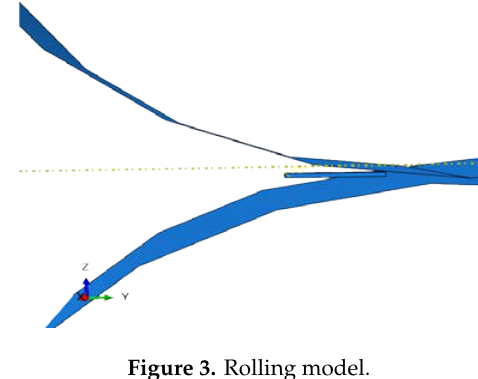
Figure 3. Rolling model. Figure 3. Rolling